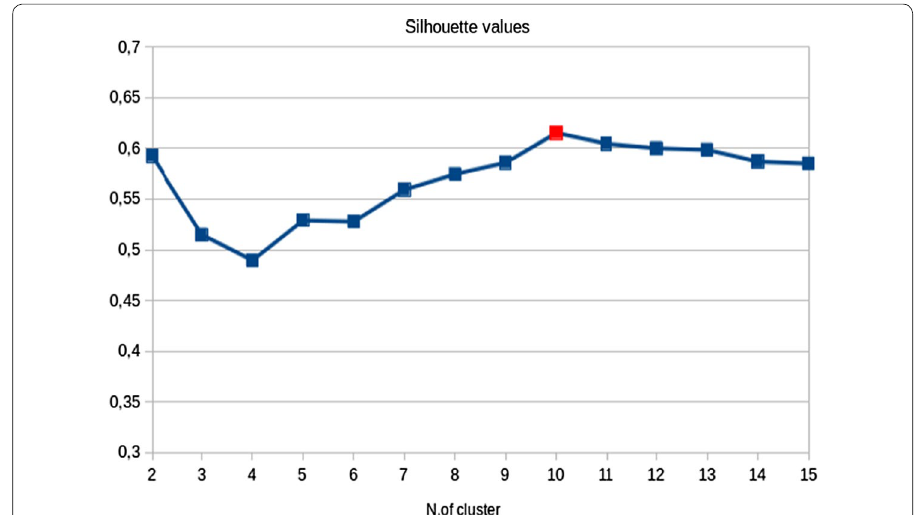
Fig. 4 Values of Silhouette. The best value is for 10 clusters (in red)